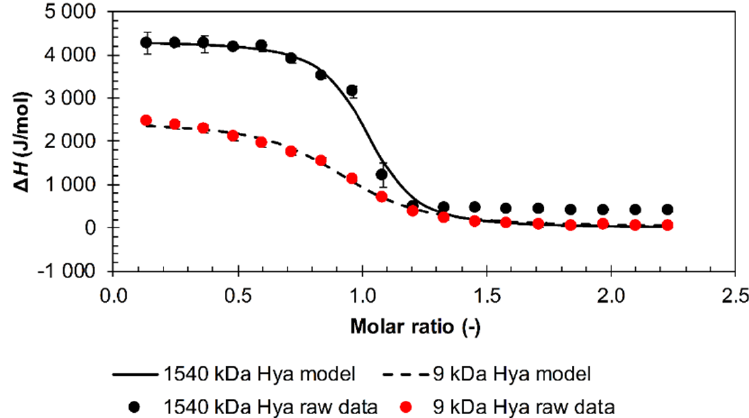
Figure 6. ITC records for the titration of arginine dodecamer in hydrochloride form into 9 and 1540 kDa hyaluronan solutions in water (25 °C). Single binding site models were used for data evaluation.